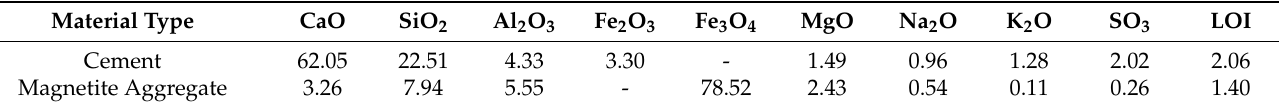
Table 1. Chemical composition of cement and aggregates (wt.%).